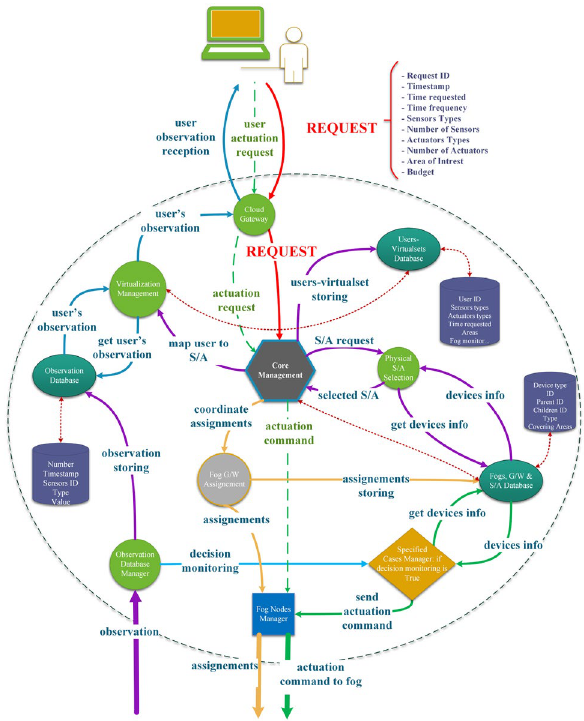
Figure 2. Cloud design with all its components and types of internal messages among its